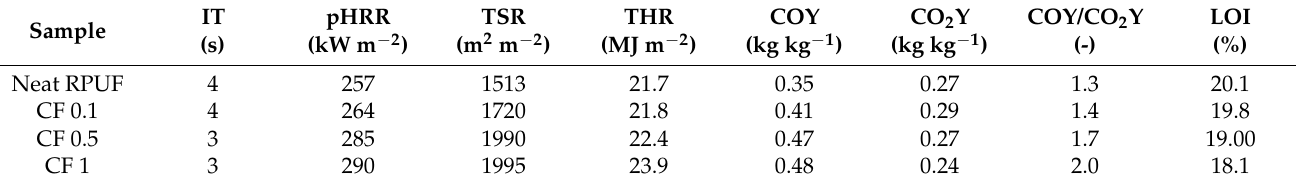
Table 6. Main results from the cone calorimeter tests for the studied RPUF